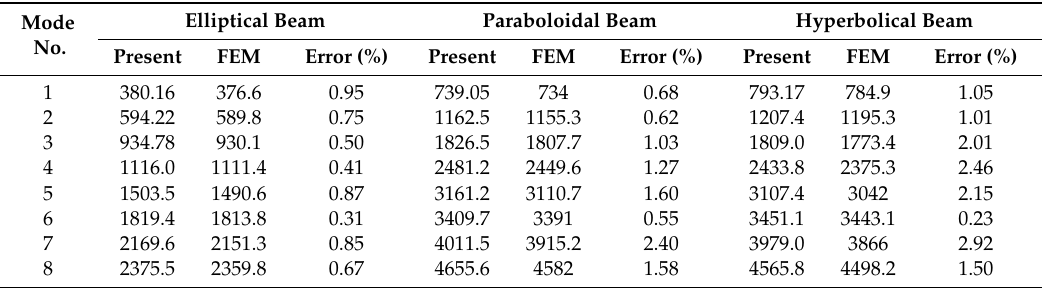
Table 3. Comparison of frequencies (first eight modes) for C-C elliptical, paraboloidal, and hyperbolical curved laminated composite